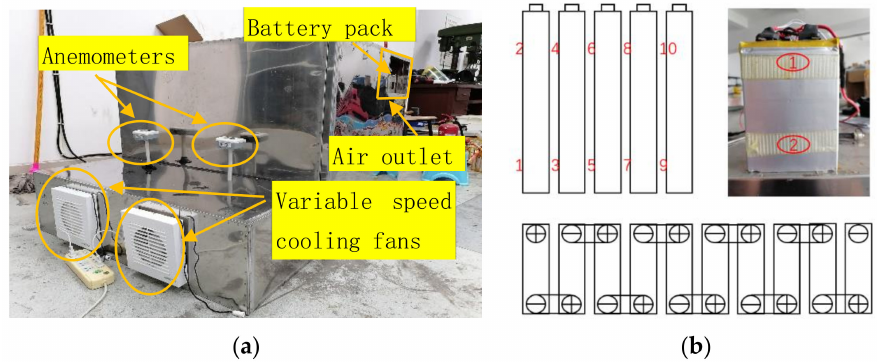
Figure 4. Battery pack heat dissipation test bench: ( a ) the experimental devices of the air-cooling system; ( b ) the positions of the temperature sensors.